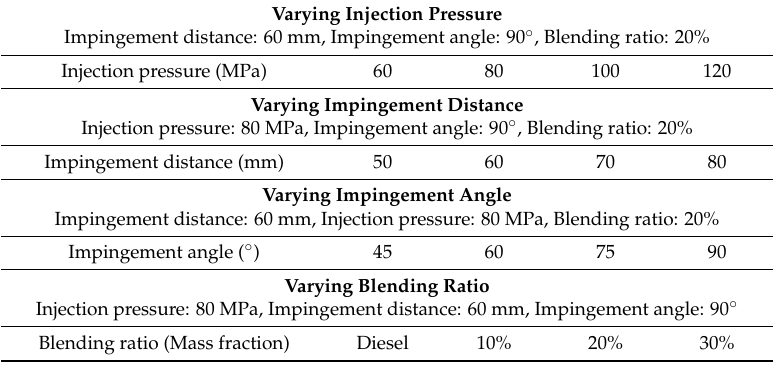
Table 3. Experimental conditions.